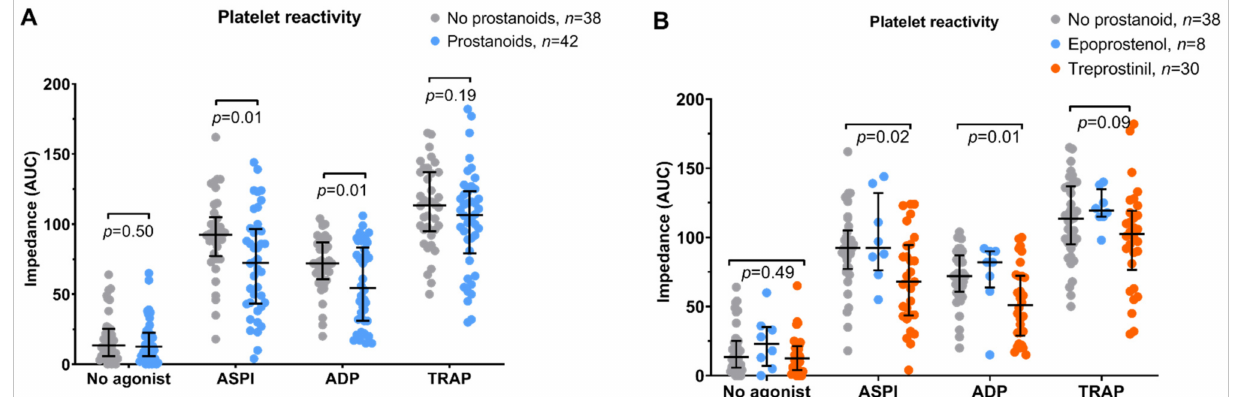
Figure 2. ( A ) Platelet reactivity in blood in response to arachidonic acid (ASPI test), adenosine diphosphate (ADP test), and thrombin receptor-activating peptide-6 (TRAP test). Unstimulated platelets (no agonist) were used as a negative control. Panel A: Patients receiving prostacyclin analogues and not treated with prostacyclin analogues. Values were compared using the Mann–Whitney U test and shown as the median and interquartile range. ( B ) Comparison between no prostacyclin analogues, epoprostenol, and treprostinil). Values were compared using the Kruskal—Wallis test with Dunn’s correction for multiple comparisons and shown as the median and interquartile range. AUC—area under the curve.